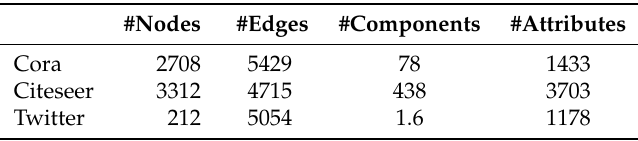
Table 1. Statistics of three network